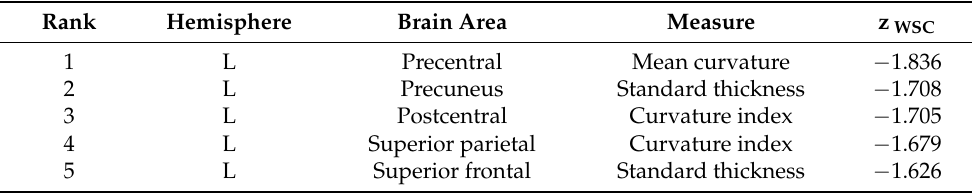
Table 6. Top-ranking brain features of weighted spectral centrality (WSC) (Cluster